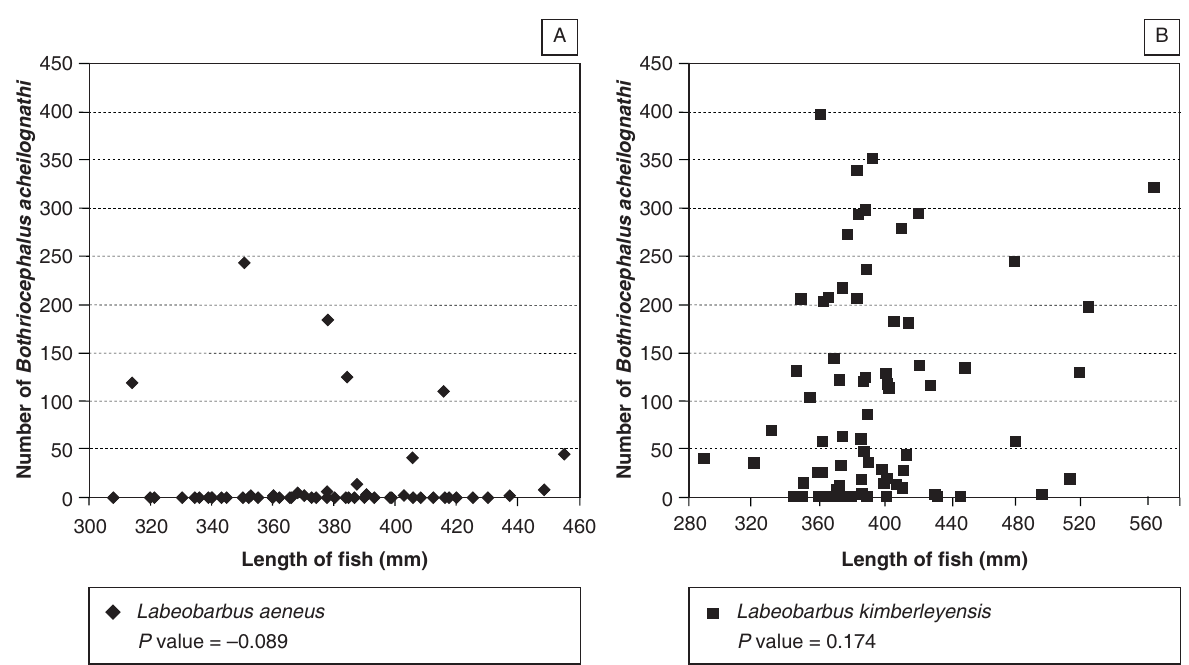
FIG. 5 Graphs showing that there was no correlation between the size (fork length) of Labeobarbus aeneus (A) and Labeobarbus kimberleyensis (B) sampled during the four seasons and the number of Bothriocephalus acheilognathi . The statistically cal- culated P value is